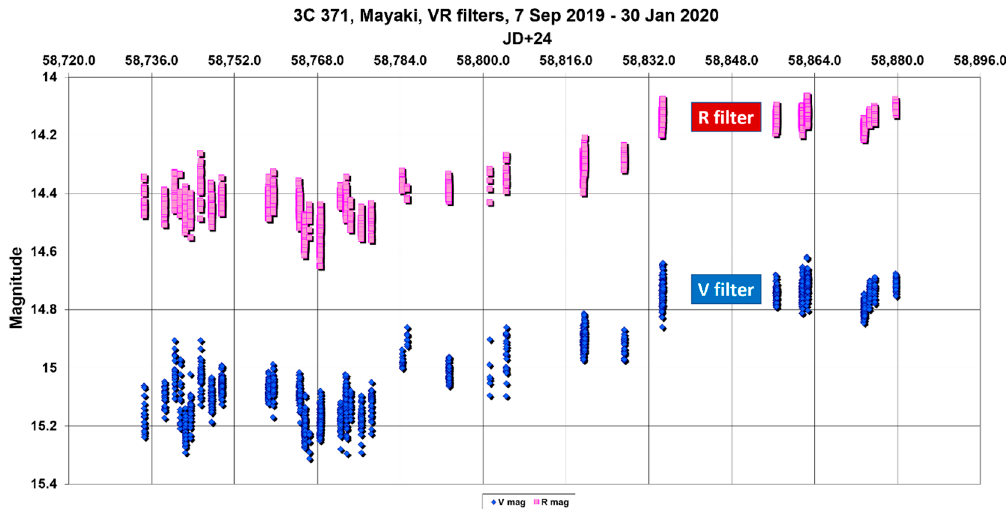
Figure 16. Common light curves of the source 3C 371, obtained at the Mayaki observatory (Ukraine) in V, R bands, during the time interval 7 September 2019–30 January 2020.